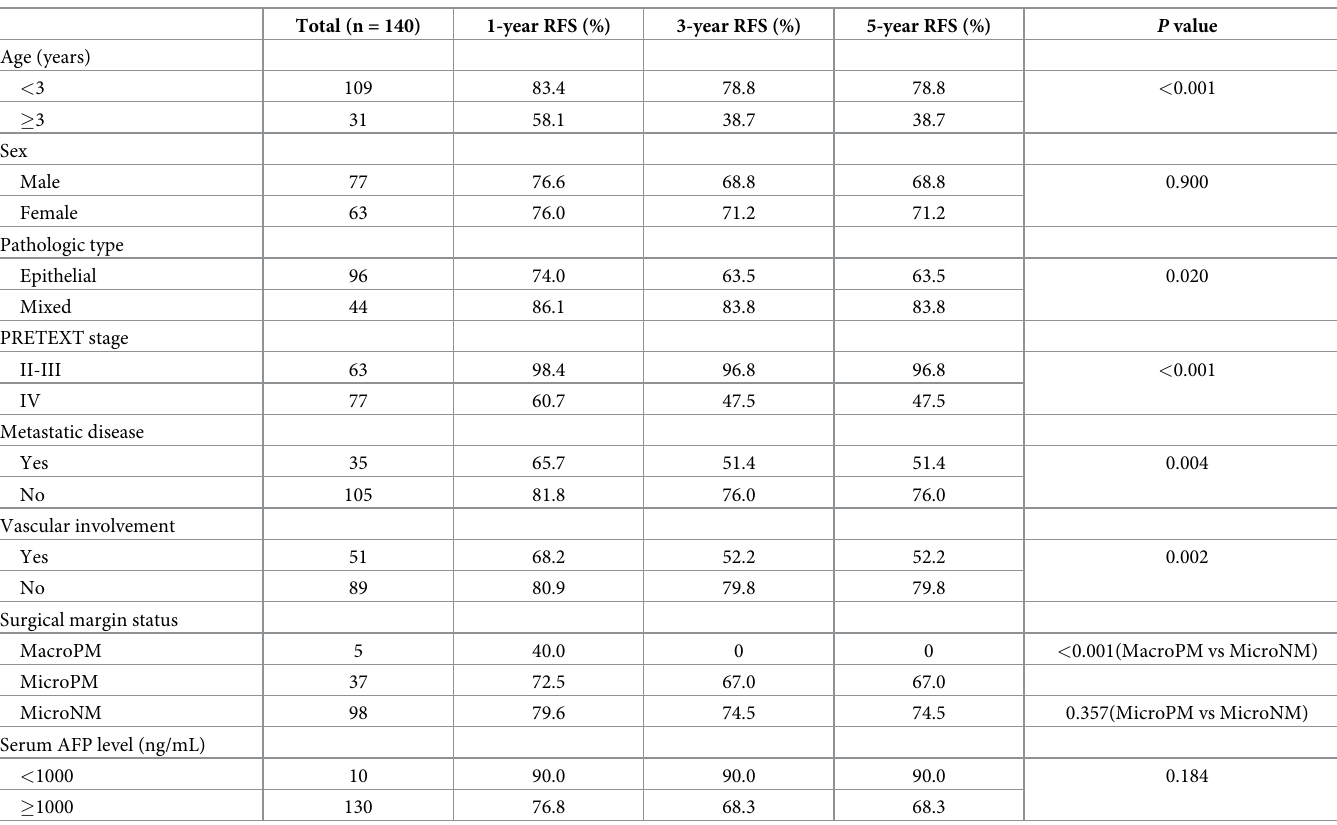
Table 3. Comparison of RFS in each cohort of 140 children with initial